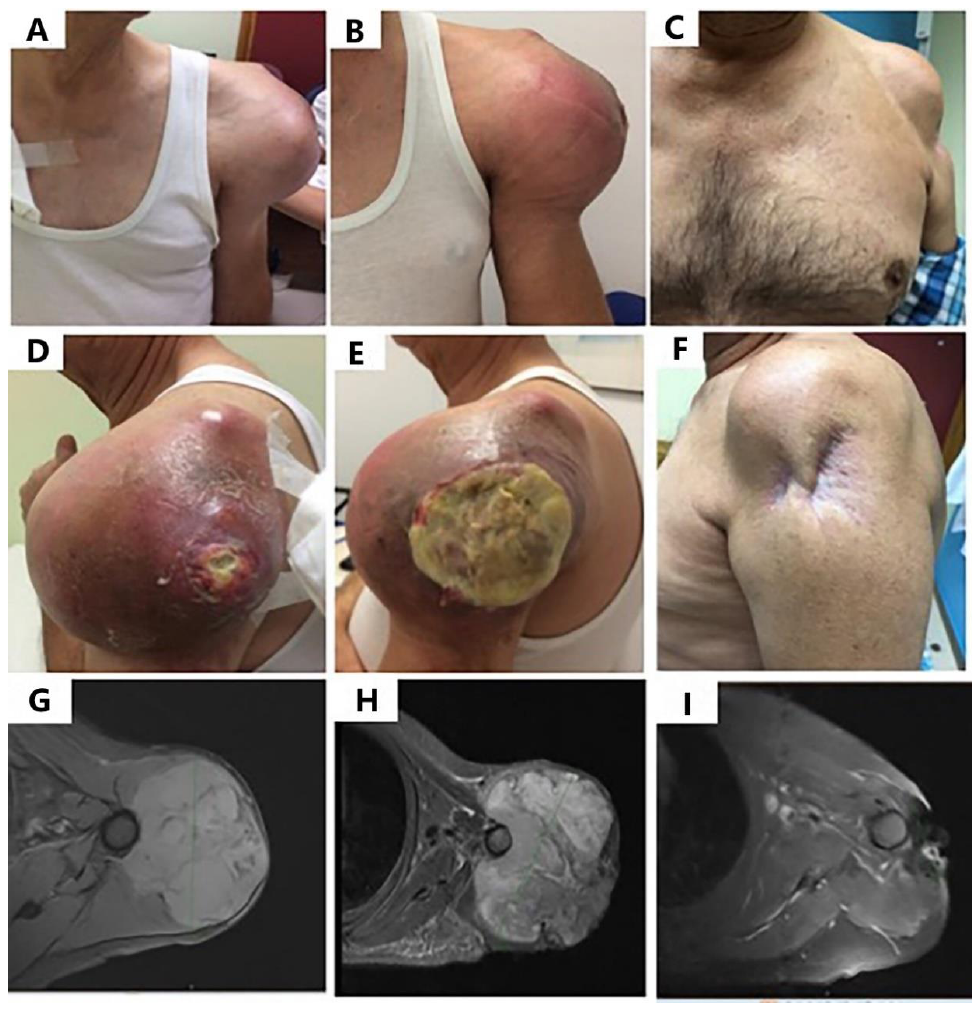
Figure 1. Clinical and RECIST partial response in a 59-year-old man with a metastatic leiomyosarcoma. The patient received trabectedin plus RT (30 Gy in 10 fractions) after rapid progression to doxorubicin-olaratumab. ( A , D ) Baseline study (November 2018); ( B , E ) Skin ulceration after Cycle 1 of trabectedin and RT (Dec 2018); ( C , F ) Long-lasting partial response (September 2019). ( G – I ) MRI images. ( G ) Baseline to previous line (September 2018); ( H ) Baseline to trabectedin-RT (November 2018); ( I ) Partial response (August 2019).